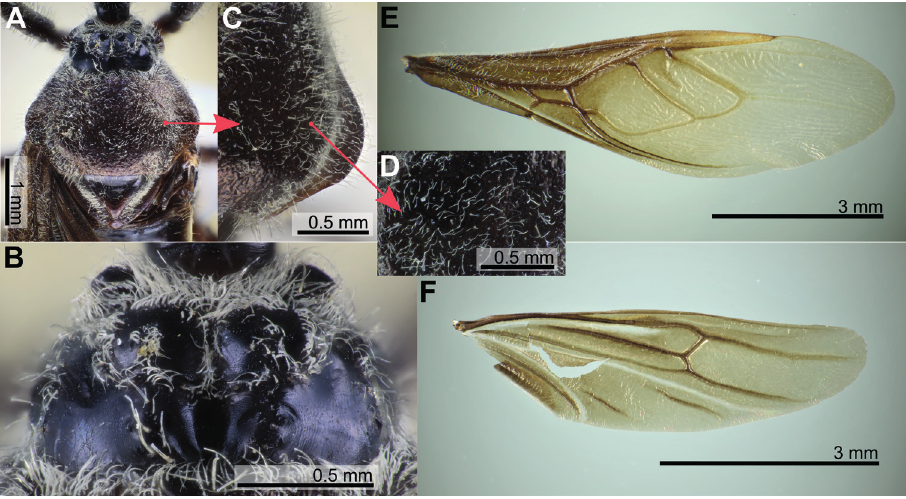
Figure 17. Biasticus griseocapillus Ha, Truong & Ishikawa, sp. nov., holotype, ♀ , HNL2018-038 A pronotum in dorsal view B anterior pronotal lobe in dorsal view C, D setae on posterior pronotum E right hemelytron F right hind